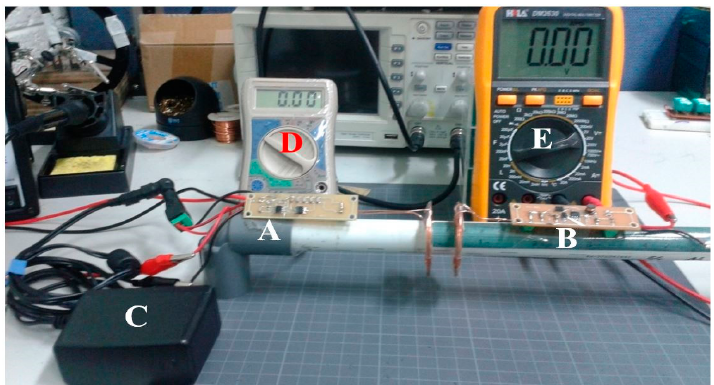
Figure 15. Experimental setup. A is the wireless power transmitter apparatus, B is the wireless power receiver apparatus, C is the direct current (DC) power source, D and E are the multimeter.